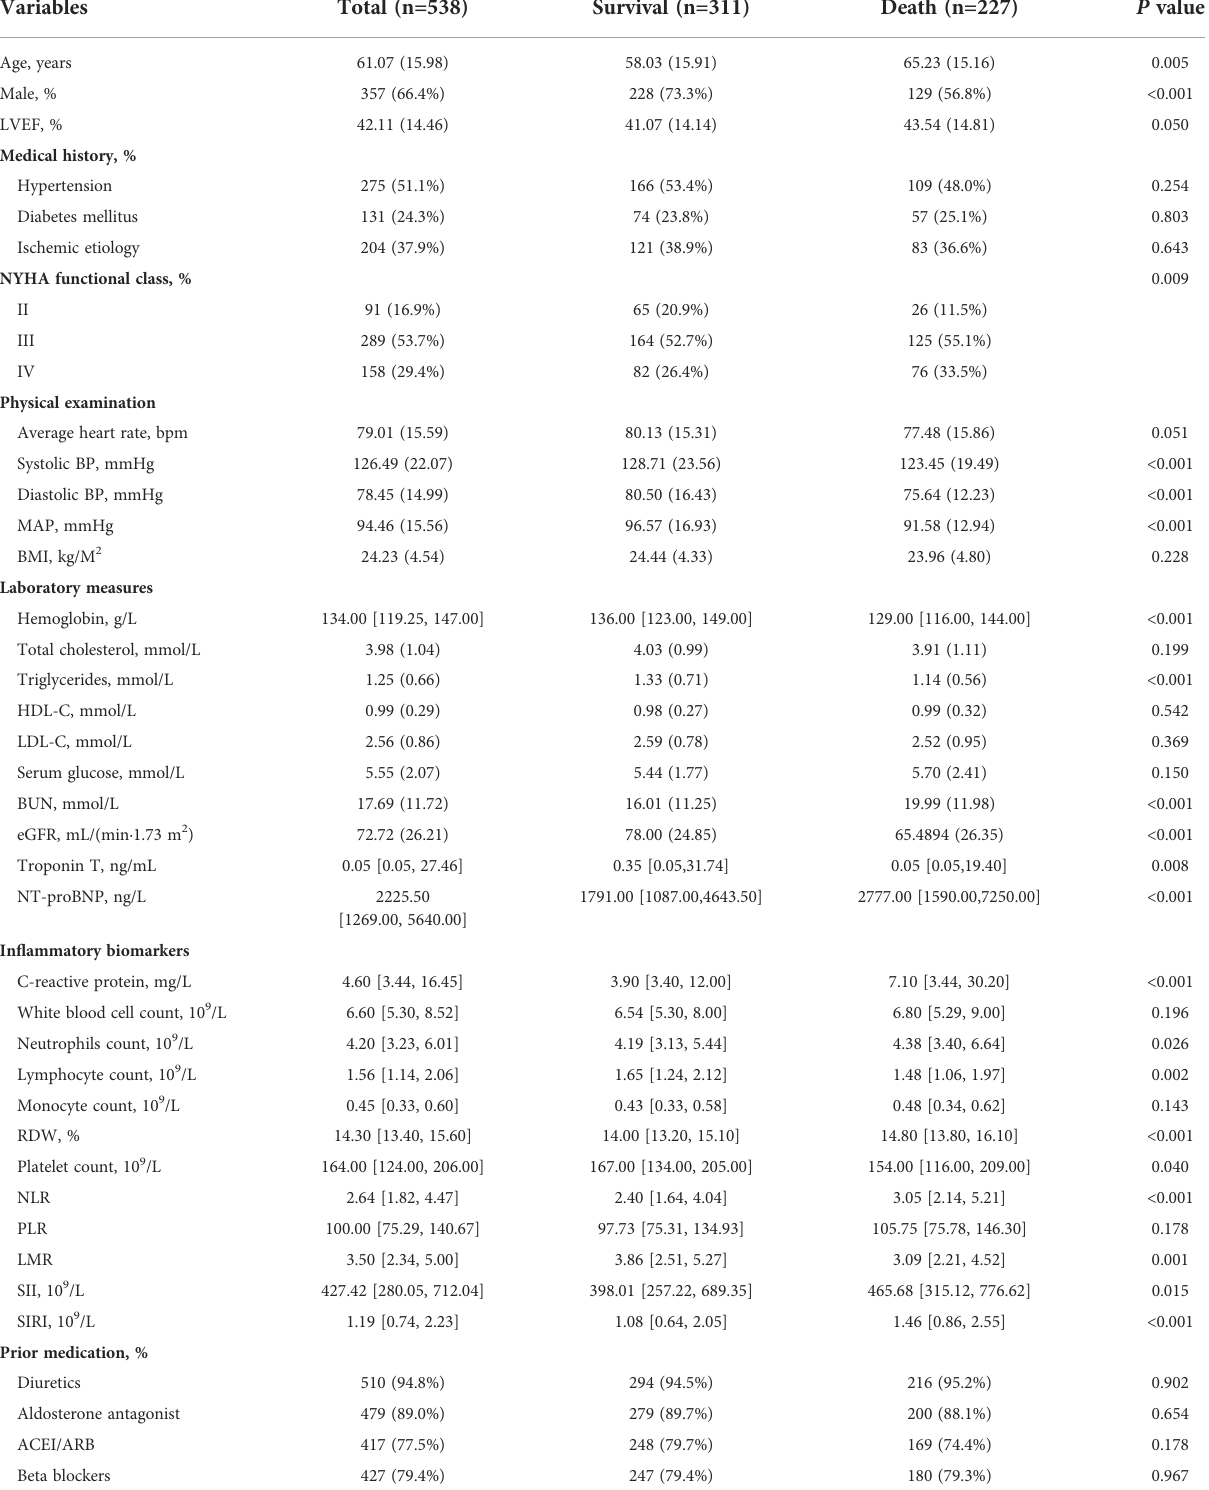
TABLE 1 Baseline characteristics in patients with